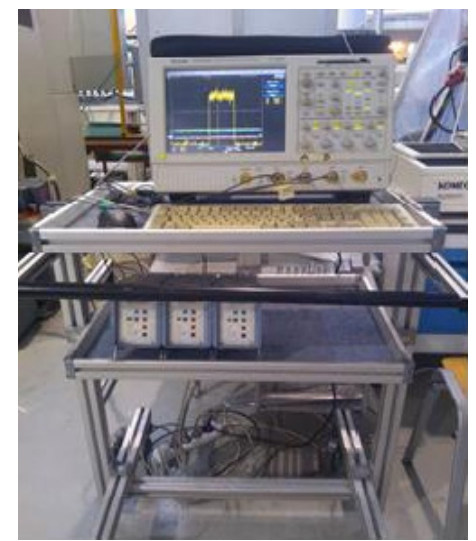
Figure 5. Signal amplifier and oscilloscope as a part of measuring